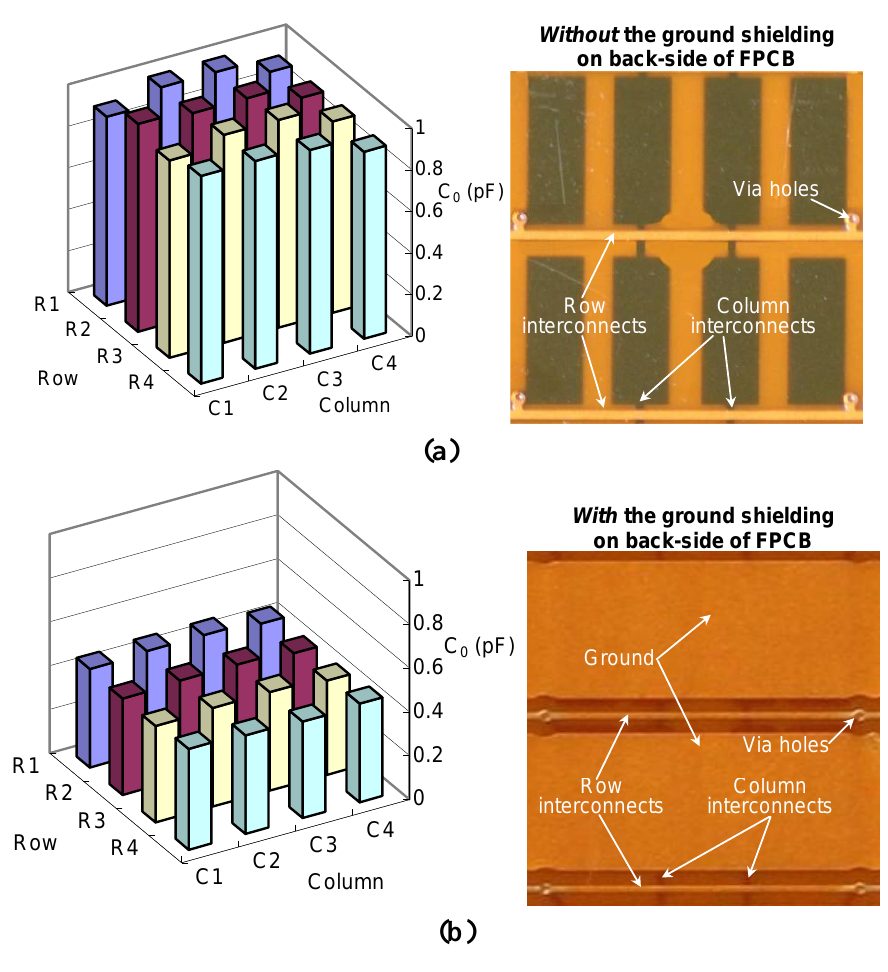
Figure 9. The measured initial capacitances of the sensing mechanisms (a) without the ground shielding on the back-side of layer-III, and (b) with the ground shielding on the back-side of